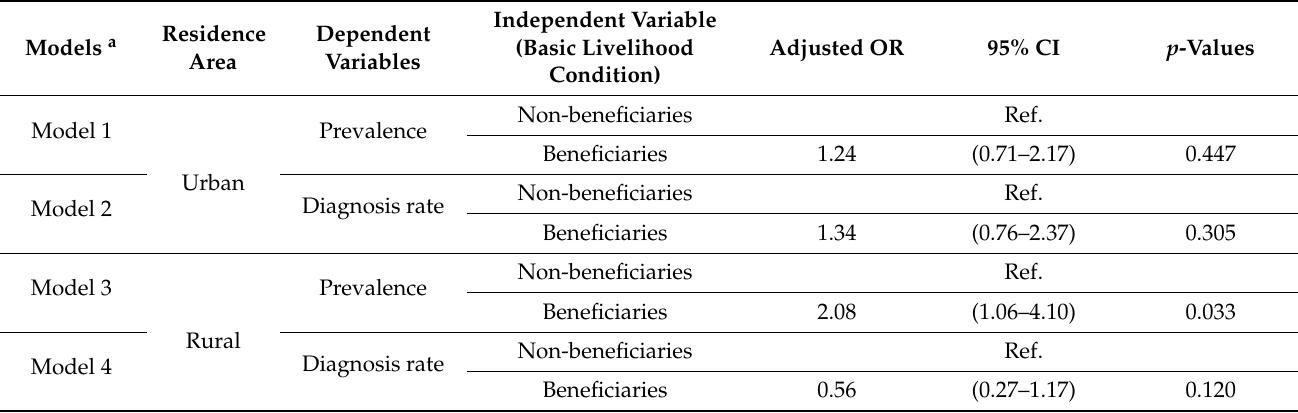
Table 4. Multivariate logistic regression analysis of the influence of the basic livelihood condition on the osteoporosis prevalence and diagnosis rate in the rural and urban